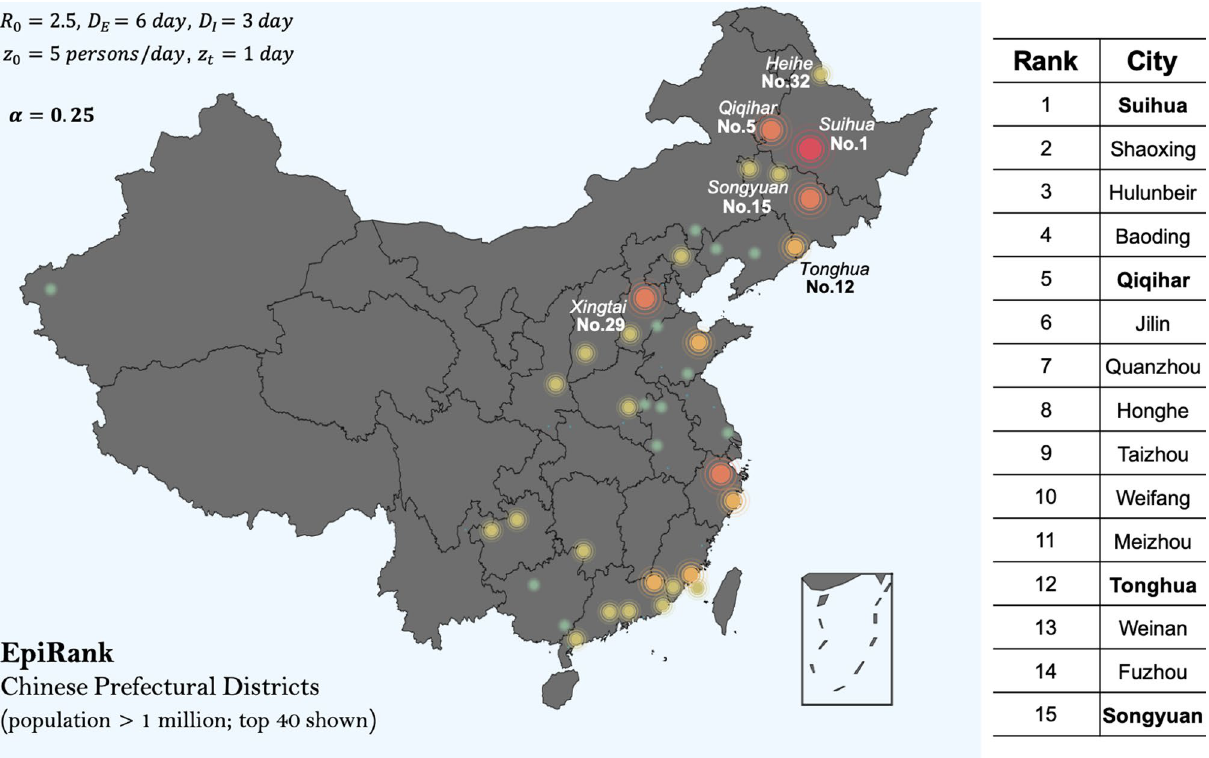
seeded by a 1-day zoonotic force at the strength of 5 persons/day ; α = 0.25 . Table: top 15 ranks. Six hotspots (Tonghua, Songyuan, Suihua, Qiqihar, Heihe, Xingtai) are successfully indicated by high rankings (four in top 5% and all six in top 10%). The map is generated using the python package pyecharts (http:// pyech arts. herok uapp.